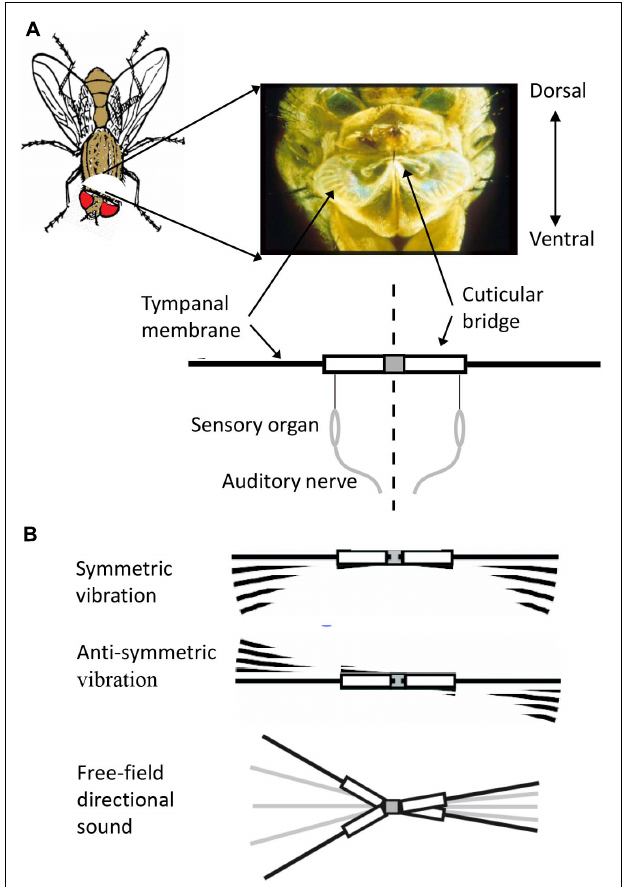
FIGURE 1 | (A) Ormia auditory system. Ears are located behind the head – less than 0.5 mm apart. Mechanical coupling between eardrums, via the cuticular bridge, allows resolution of miniscule interaural time differences – the only acoustic directional cue available. Auditory receptors in each ear are attached to a single point at the end of the cuticular bridge. (B) Symmetric and antisymmetric modes of vibration. Symmetric mode (upper) corresponds to non-directional sound source (0 ◦ azimuth). Equal, in-phase sound pressure drives equal-amplitude, in-phase vibration of the two tympani, bending at the midline. In antisymmetric mode vibration (middle) the tympani vibrate with equal amplitudes and opposite phase – rocking like a teeter-totter. Sound stimulation from any direction other than 0 ◦ would elicit tympanal vibration representing a combination of these two modes resulting in unequal vibration of the two tympani